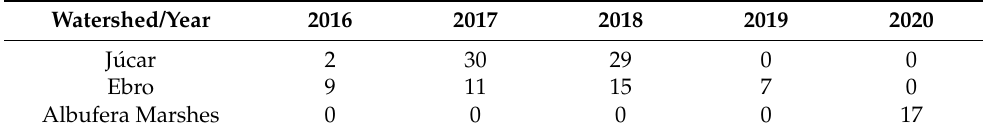
Table A2. Samples collected by year and